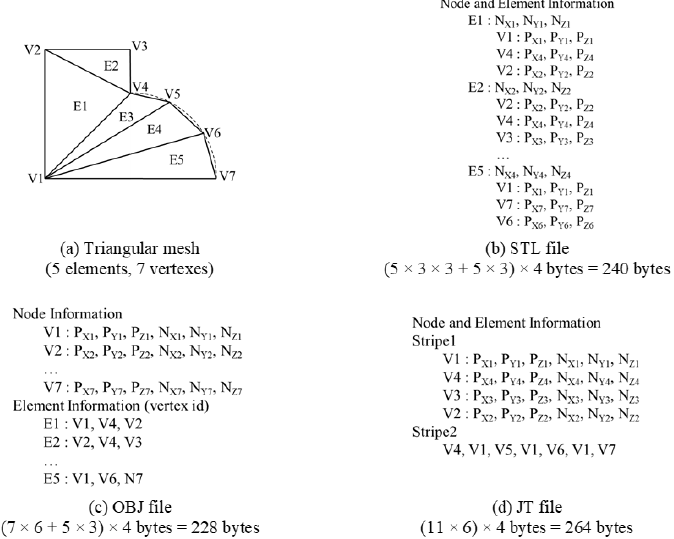
Figure 4. Comparison of data sizes for different lightweight file structures: ( a ) triangular mesh, ( b ) STL file, ( c ) Wavefront object (OBJ) file, and ( d ) Jupiter Tessellation (JT) file.